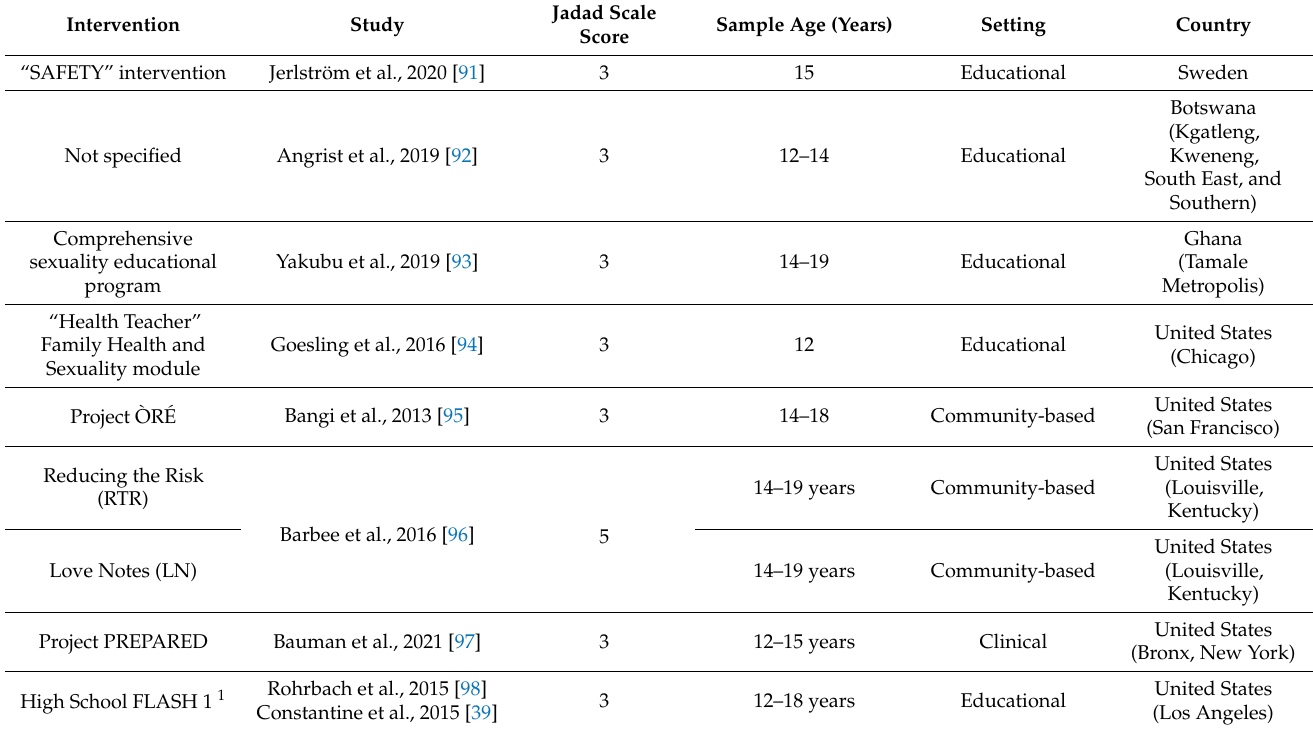
Table 2. Characteristics of included